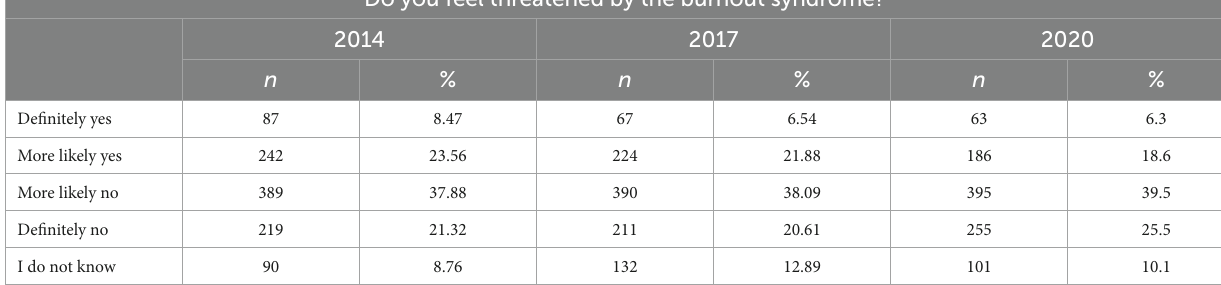
TABLE 2 Subjective threat of burnout syndrome. Do you feel threatened by the burnout syndrome?